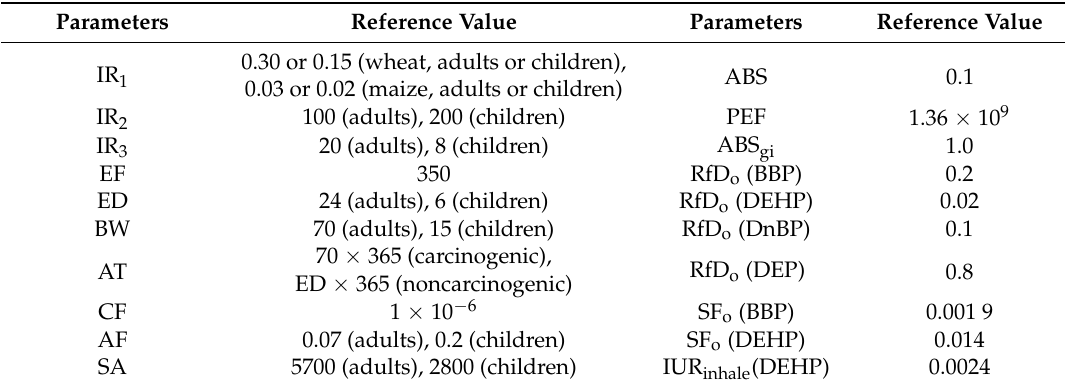
Table 3. Parameters of health risk